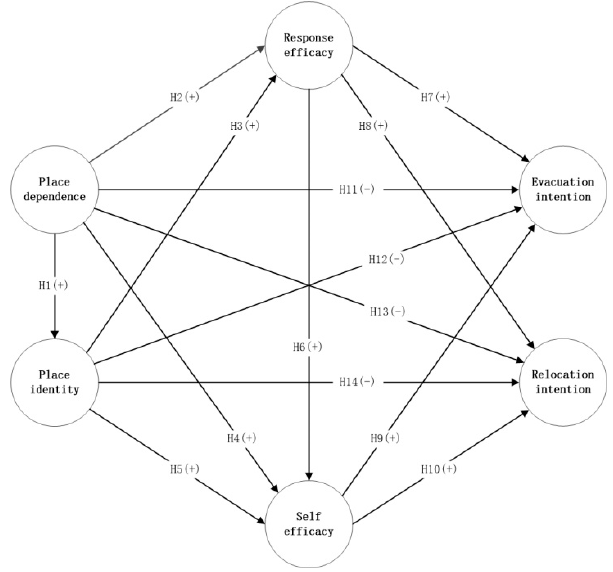
Figure 1. Conceptual framework.